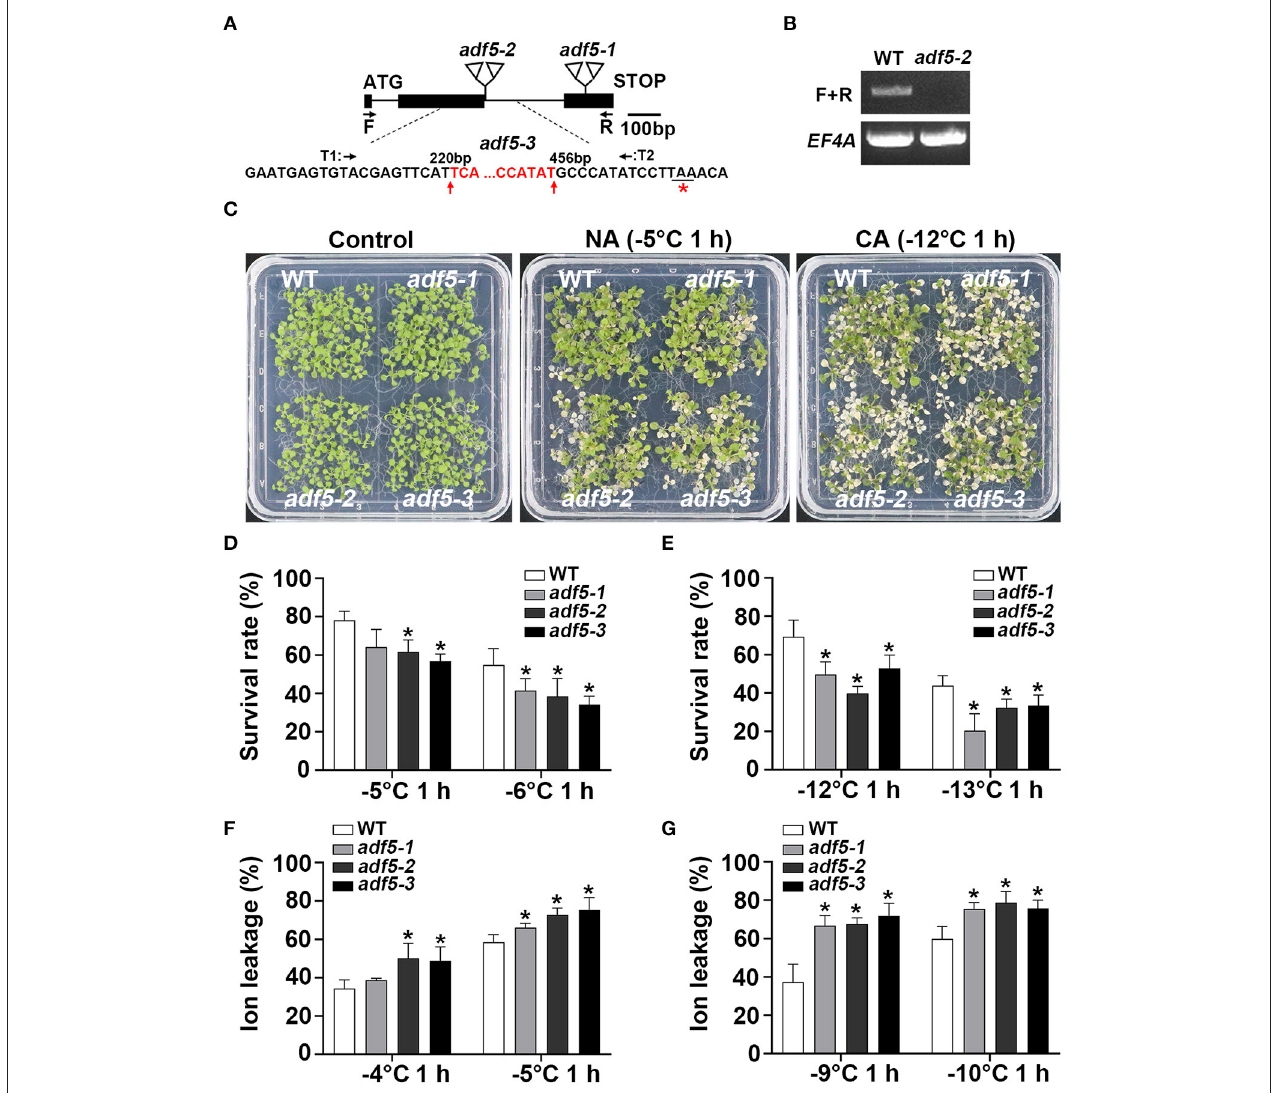
FIGURE 1 | Mutation of ADF5 results in increased freezing sensitivity. (A) Sketch map of adf5 mutants. The black square represents the exon, and the black line represents the intron. The positions of adf5-1 and adf5-2 T-DNA are shown in the triangle. F and R are amplification sites of ADF5 for RT-PCR or identification of adf5-3 . T1 and T2 are specific Cas9-splicing sites. The red base is deleted in adf5-3 , and the red asterisk is the edited termination site. (B) Expression of full length ADF5 in WT and adf5-2 . EF4A is used as an internal control gene. (C) Freezing phenotypes of WT and adf5s , each material contains ∼ 40 seedlings, which were directly used for freezing treatments (non-cold-acclimated, NA), or treated at 4 ◦ C for 3 days (cold-acclimated, CA) before freezing treatment. (D,E) Survival rate of WT and adf5s . After 3–5 days of recovery under normal growth conditions, the survival rate was calculated. The data are the means of three biological replicates ± SD ( n = 40 for each replicate). Asterisks indicate statistically significant differences ( P < 0.05, one-way ANOVA with a Dunnett’s multiple comparisons test). (F,G) Ion leakage of WT and adf5s . After 3 weeks of normal growth in soil, the fully developed rosettes of seedlings were used for freezing treatment to obtain ion leakage under NA and CA conditions. The data are the means of three biological replicates ± SD ( n = 5 for each replicate). Asterisks indicate statistically significant differences ( P < 0.05, one-way ANOVA with a Dunnett’s multiple comparisons